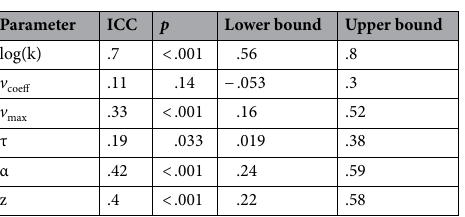
Figure 5. Posterior distributions of the remaining parameters of the DDM S model. Colored bars represent the corresponding 95% HDIs. ( a ) Posterior distributions of the τ parameter (non-decision time) for all three sessions. ( b ) Posterior distributions of the α parameter (separation between decision boundaries). ( c ) Posterior distributions of the z parameter (bias towards one decision option). ( d ) Pairwise difference distributions between the posterior distributions of the τ parameters of the three sessions. ( e ) Pairwise difference distributions between the posterior distributions of the α parameters of the three sessions. ( f ) Pairwise difference distributions between the posterior distributions of the z parameters of the three sessions.